Question: Write a caption explaining this figure to a reader.
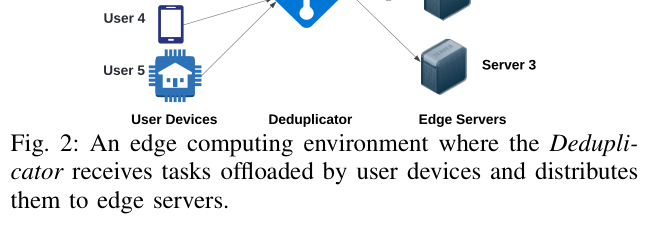
Answer: ). Distributing similar tasks to the same edge server(s) for a wide spectrum of applications may overload certain servers, while leaving others underutilized, thus causing load imbalances among servers. This signifies the need in edge computing environments to facilitate computation reuse, while at the same time balancing the load imposed on edge servers. To this end, in this paper, we propose the Deduplicator, a middlebox that aims to simultaneously achieve these functions. How is the Deduplicator different than traditional load bal- ancing: Several load balancing techniques have been proposed over the years. These techniques do not consider the similarity between the input data of tasks, thus they do not facilitate computation reuse during the distribution of tasks towards servers. For example, load balancing based on consistent hashing [13] provides a session-persistent connection between a user and a server by hashing the header fields of user requests. A naive solution cou